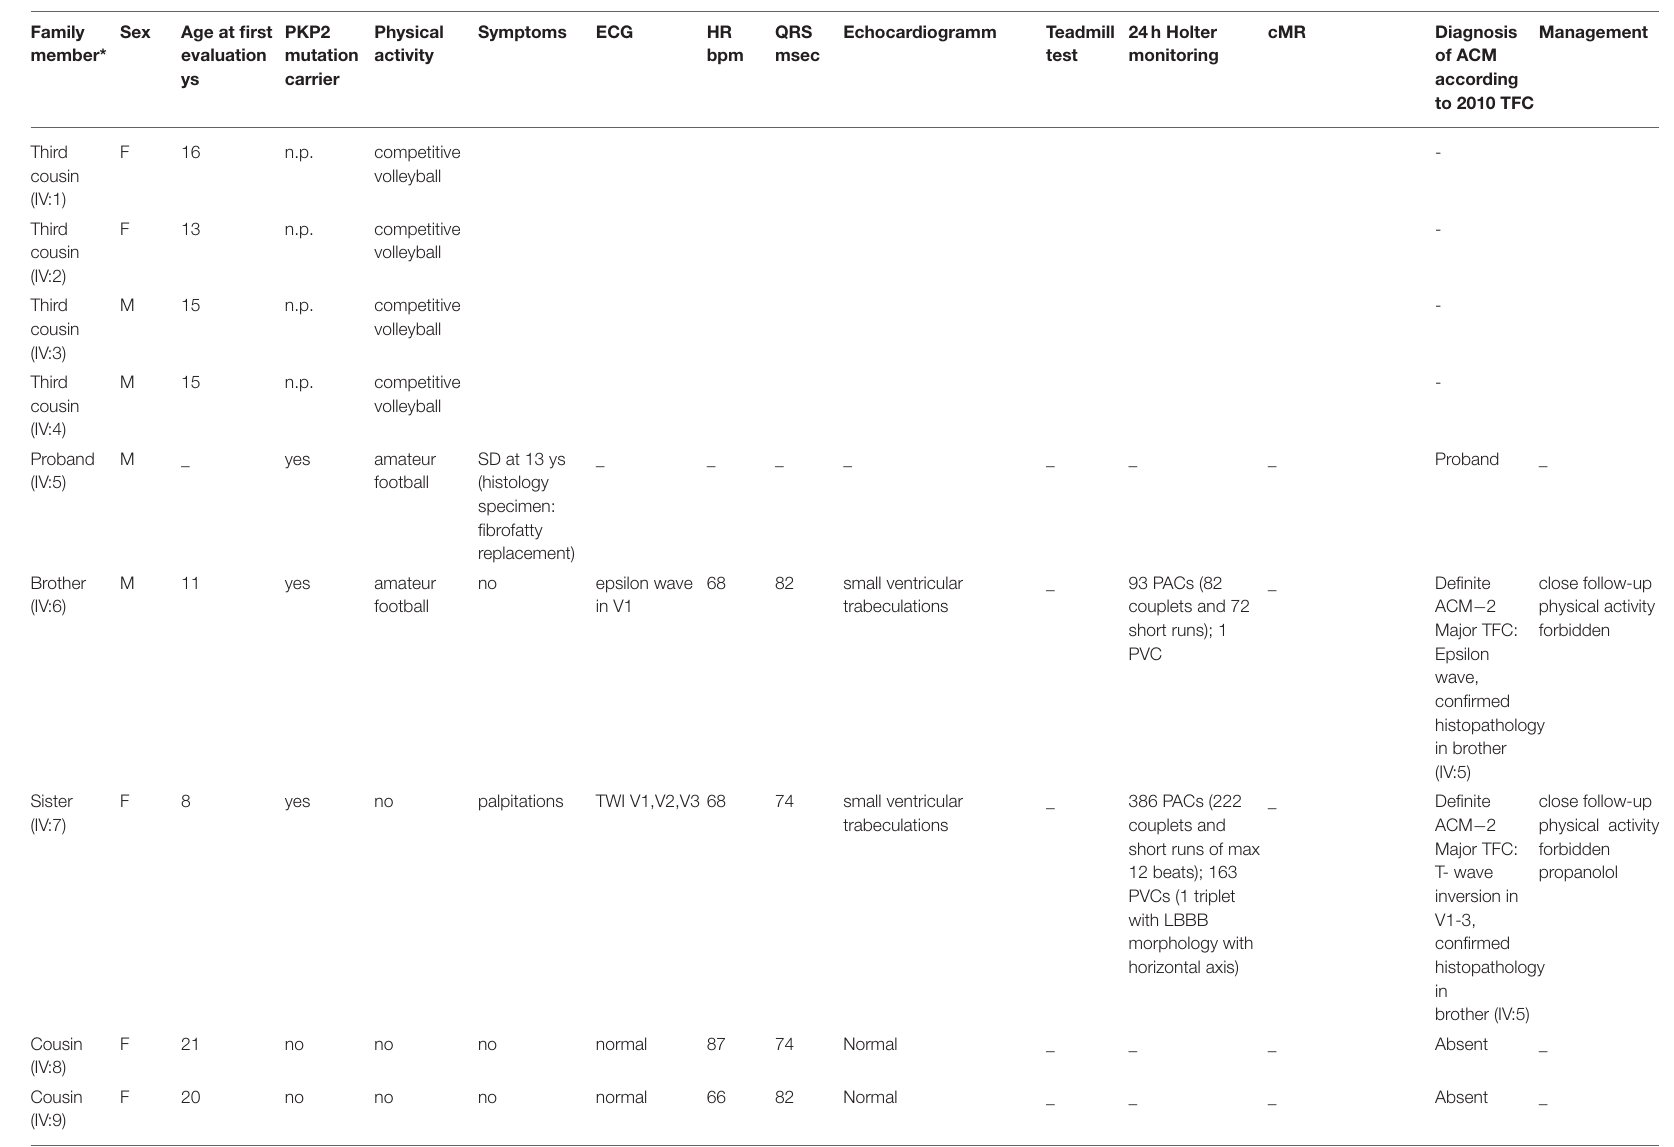
TABLE 1 | Clinic and genetic features of family members. Family member*